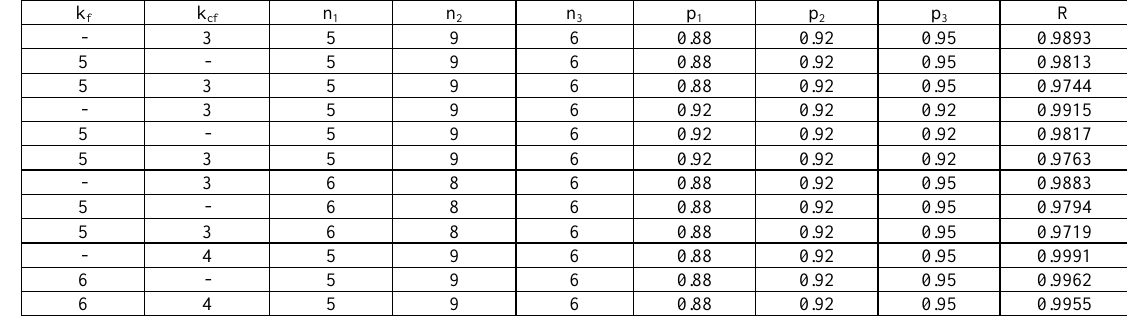
Table 6. The reliability of a two change points system TFCF.